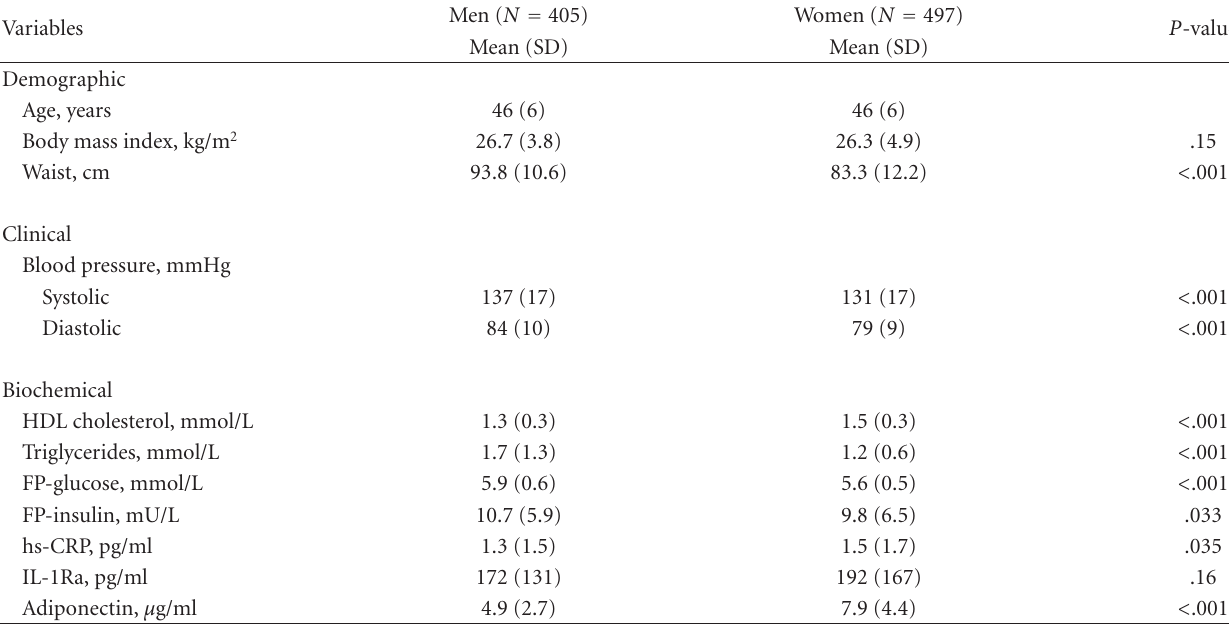
Table 1: Demographic, clinical, and biochemical characteristics of the study